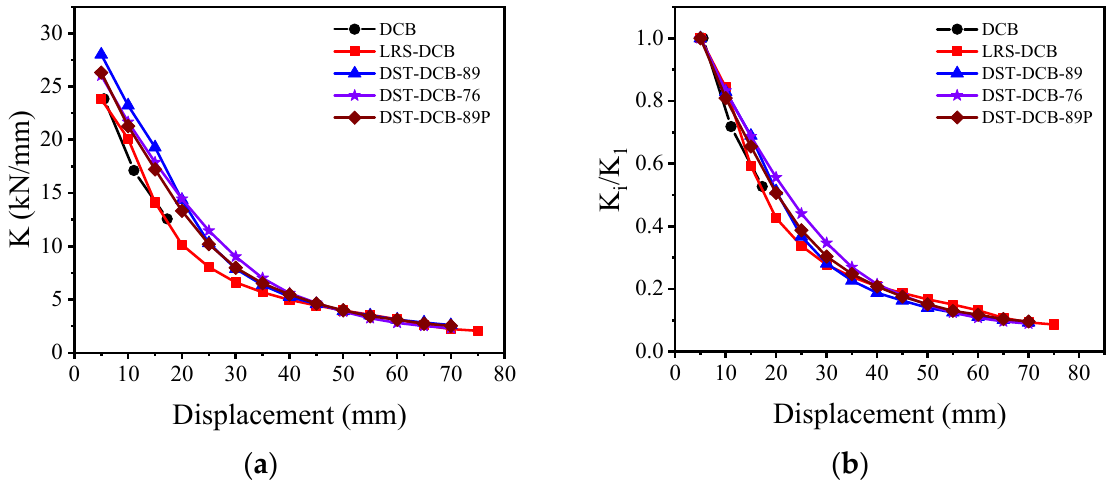
Figure 13. Stiffness degradation: ( a ) secant stiffness; ( b ) normalized stiffness.